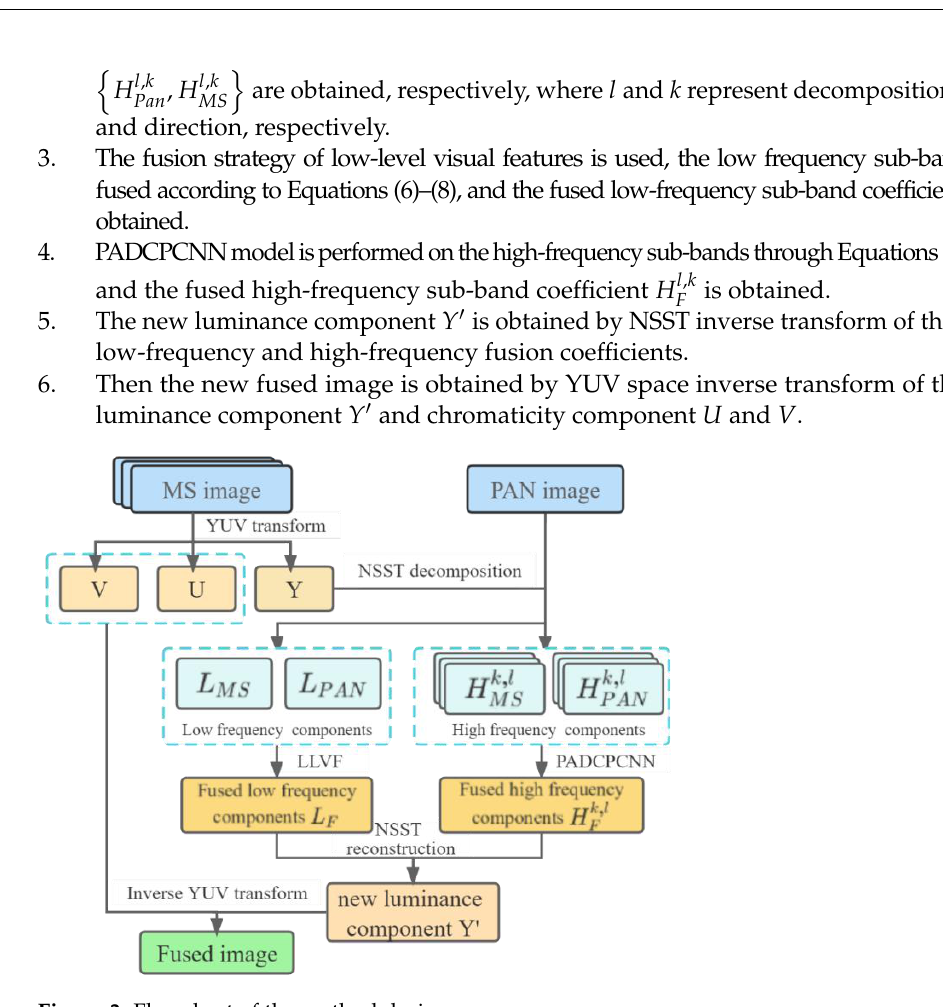
( e2 ) Figure 4. Five sets of multispectral image and panchromatic image. ( a1 ) PAN image of QuickBird; ( a2 ) MS image of QuickBird e; ( b1 ) PAN image of SPOT-6; ( b2 ) MS image of SPOT-6; ( c1 ) PAN